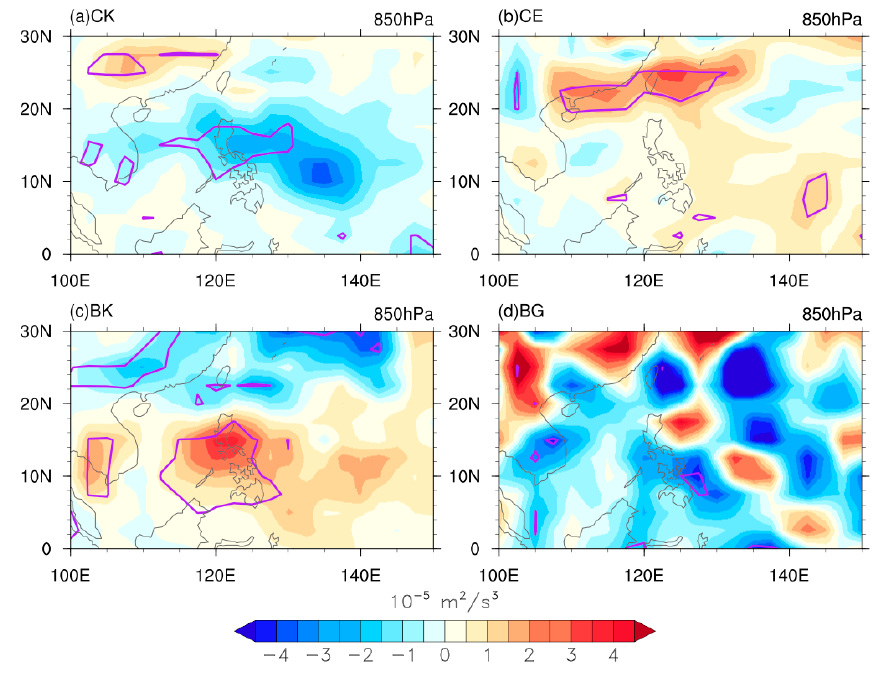
Figure 4. Difference in terms: ( a ) CK; ( b ) CE; ( c ) BK; and ( d ) BG at 850 hPa, between Pos_year and Neg_year, in units of m 2 /s 3 ; purple contours indicate the 0.05 significance level.